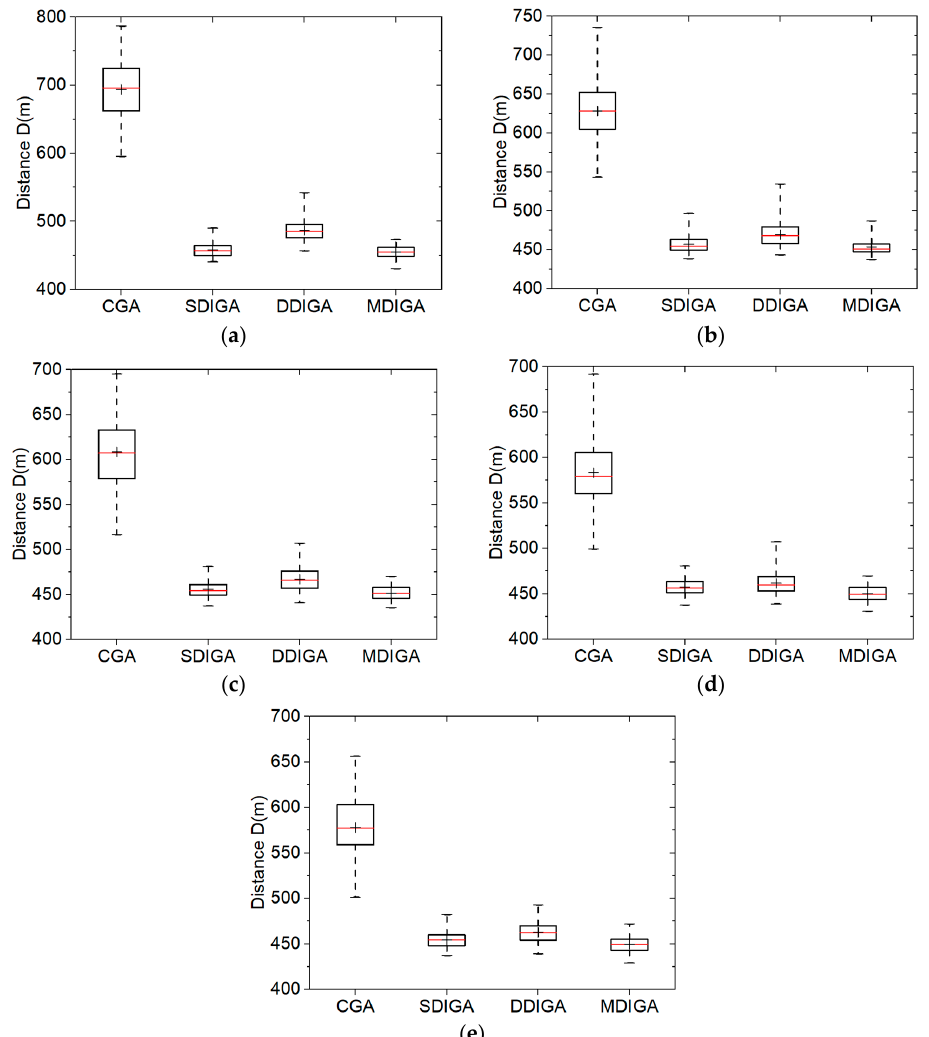
Figure 8. Solution distribution of each algorithm with five population sizes: ( a ) S = 20; ( b ) S = 40; ( c ) S = 60; ( d ) S = 80; ( e ) S = 100. Table 5. Statistical results of optimal path distance in 100 runs with five population sizes.